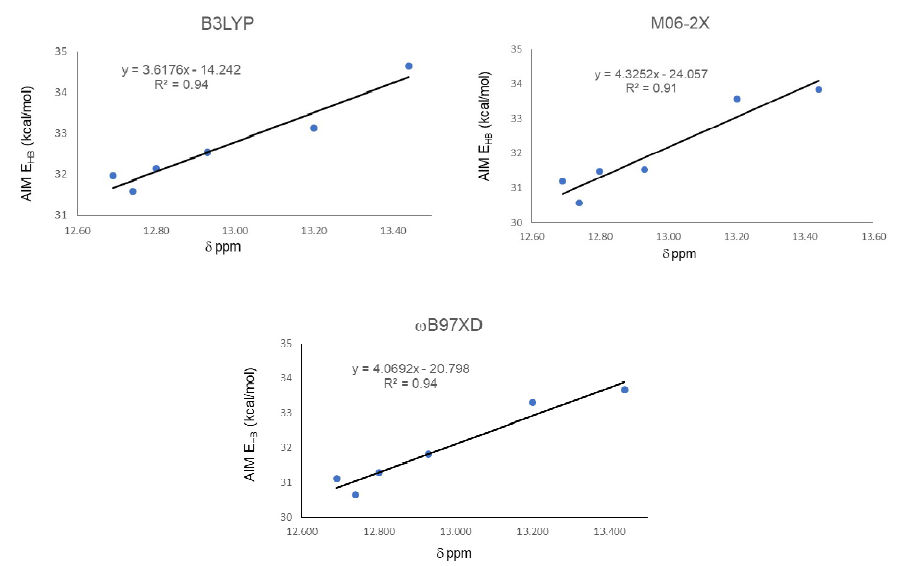
Figure 7. Correlations between hydrogen bond energy E HB (kcal/mol) and experimental chemical shifts δ (ppm) of protons involved in IMHB, excluding the weakest value.